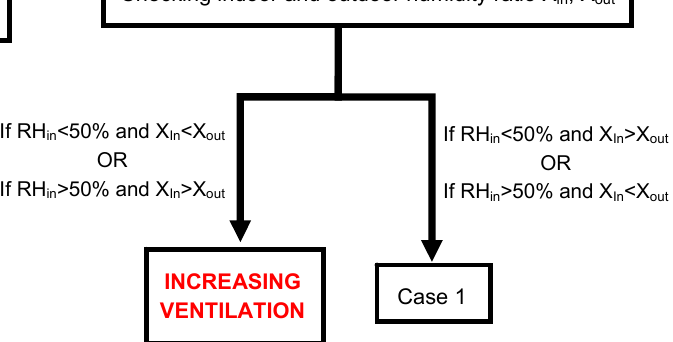
Figure 7. Variation in the indoor relative humidity, temperature, and ventilation airflow in the ethnography hall for cases with additional ventilation over a period of February to July.